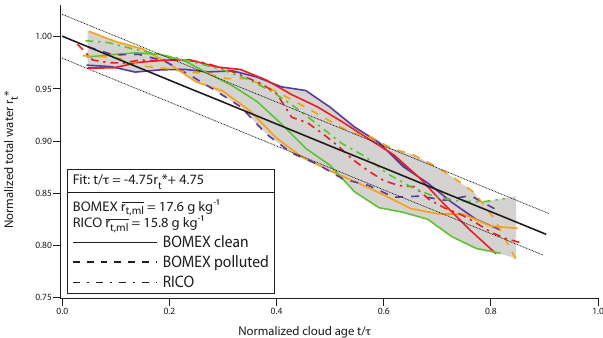
Figure 8. The time evolution of r ∗ t is well fit by linear regression. The solid black line is the fit and the dashed black lines are approx- imately one standard deviation from the mean